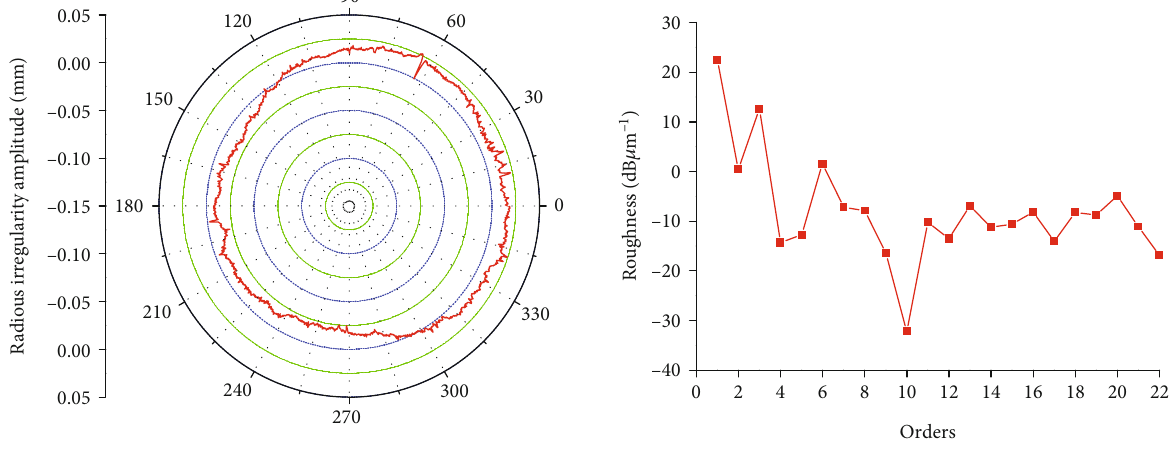
Figure 3: 2-4 wheel status of No.